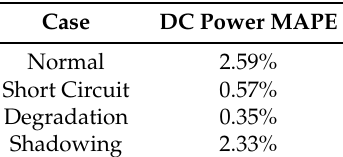
Figure 12: The proposed method consists in transmitting a frame using ⌈ α n cha ⌉ channel uses for the fi rst transmission attempt, with 0 < α ≤ 1 . In the event of a decoding error, incremental redundancy is transmitted 1 − α n cha ⌋ channel uses. making use of the rest of the available ⌊ ( )